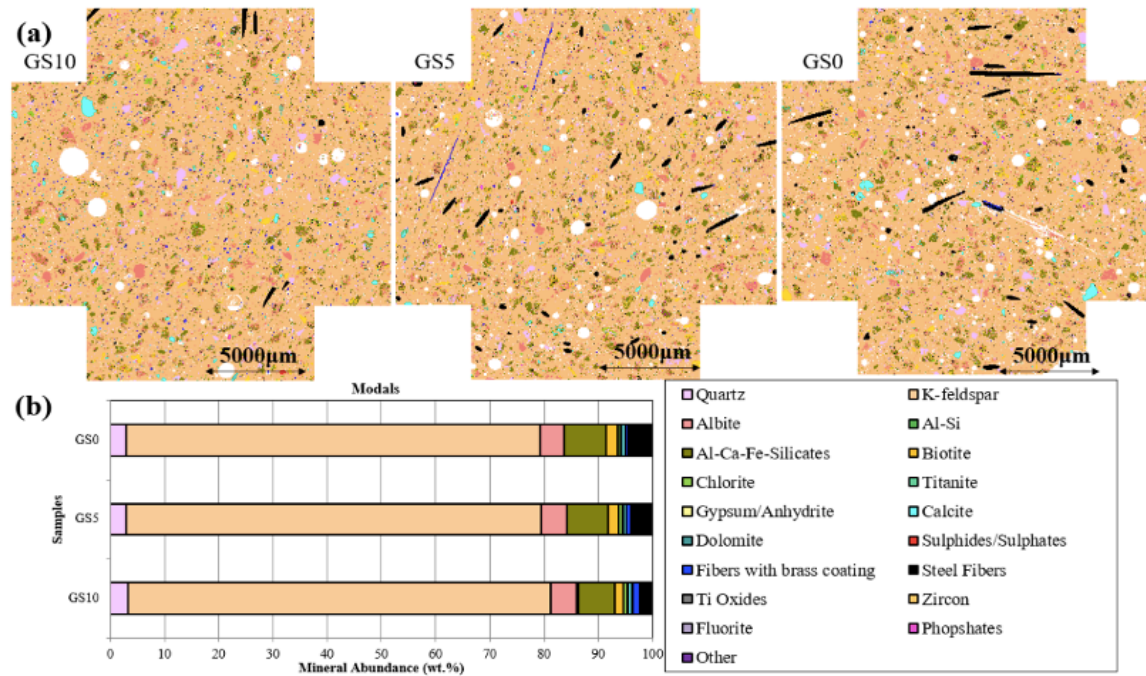
Figure 3. QEMSCAN images of HPFRGC thin sections. (a) Phase assemblage maps (b) total mineral contents of each sample by mass.